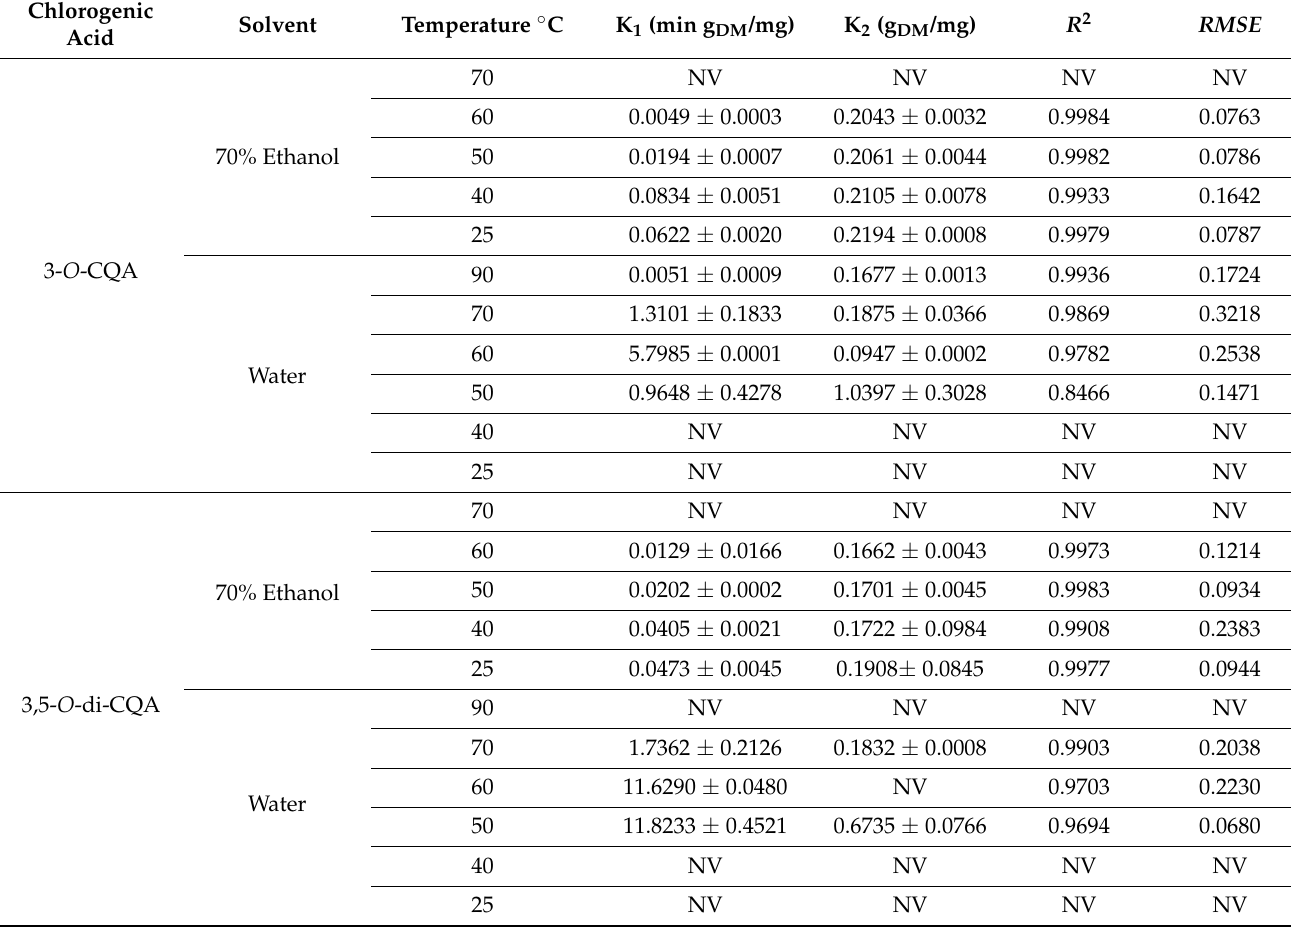
Table 2. Values of Peleg’s constants with correlation coefficient R 2 and the root mean square error ( RMSE ) in 70% ethanol and water at different